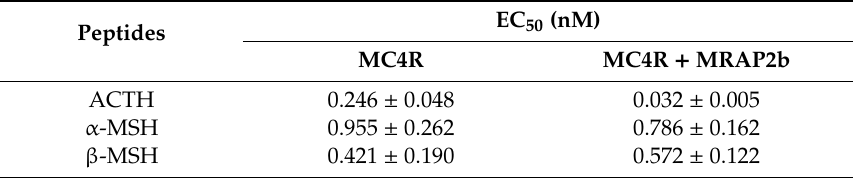
Table 2. EC 50 values of ACTH, α -MSH, and β -MSH in activating the cAMP / PKA signaling pathway in CHO cells expressing tilapia MC4R in the absence or presence of